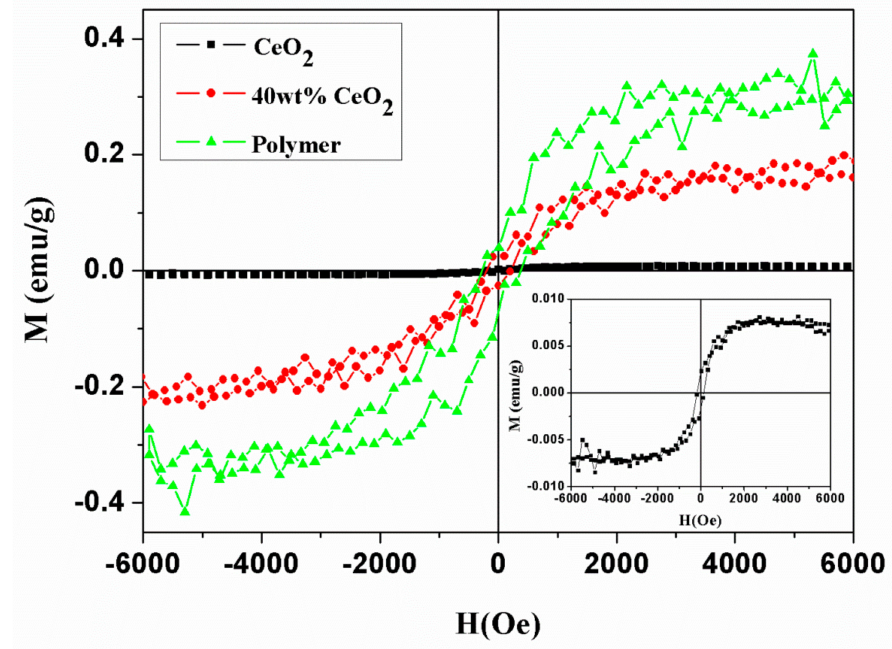
Figure 7. M-H curves of CeO 2 , polymer and polymer composite with 40 wt% CeO 2 nanoparticles. The magnified M-H curve of CeO 2 is shown in the inset.